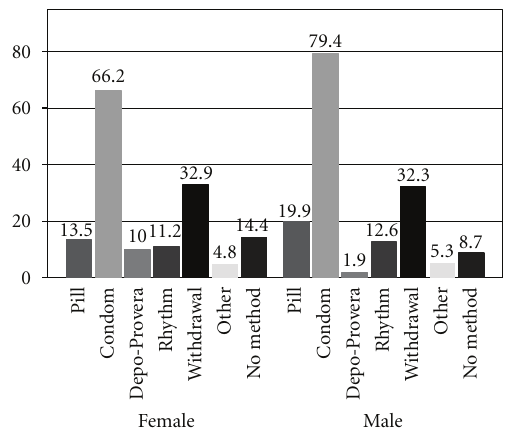
Figure 1: Prevalence of contraceptive method at last sex by gender ( N = 850). Notes: percents sum to greater than 100% because of use of dual or multiple contraceptive